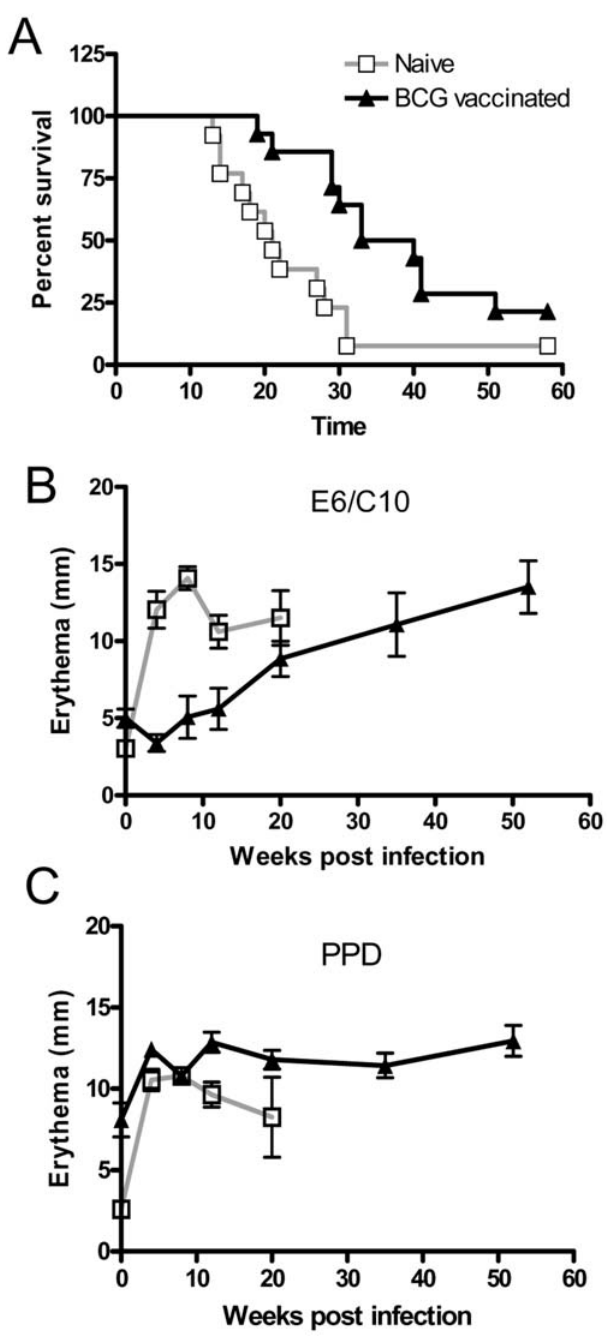
Figure 1. Survival curves and skintest responses in M. tuberculosis infected guinea pigs. Survival curves of BCG vaccinated guinea pigs (triangles) and unvaccinated guinea pigs (open squares) after M. tuberculosis infection. The animals were sacrificed when they had lost 15% of the maximum weight or had clinical symptoms indicative of severe TB (Fig 1A). Mean skin test reaction ( + / 2 SEM) for M. tuberculosis- infected unimmunized and BCG vaccinated guinea pigs (n=7), measured as erythema after intradermal injection of 2 ug E6/C10 (Fig. 1B) or 10 T.U. PPD (Fig. 1C). Each animal received a maximum of 4 tests with more than 8 weeks interval and this schedule did not sensitize naı¨ve animals. The experiment was repeated twice with the same overall result and data shown for a representative